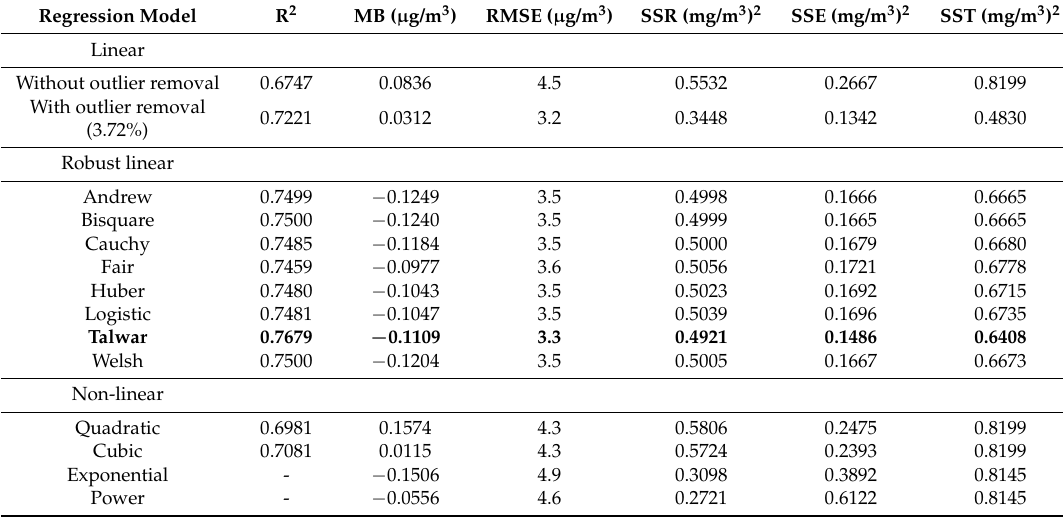
Table 3. Statistical scores of PM 10 sensor laboratory calibration (N =